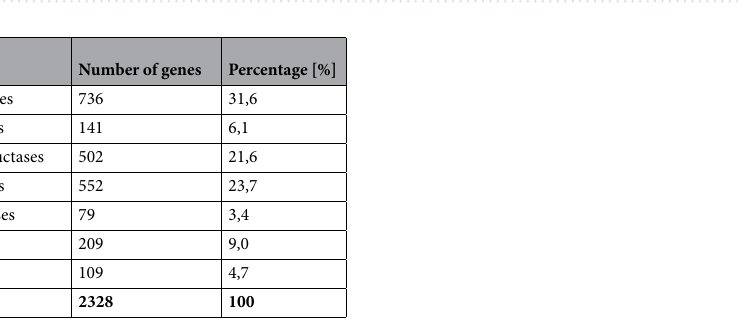
Figure 4. Growth of Enterobacter aerogenes LU2 on different carbon sources. Bars represent standard deviation. All samples were analyzed in three full biological replications.